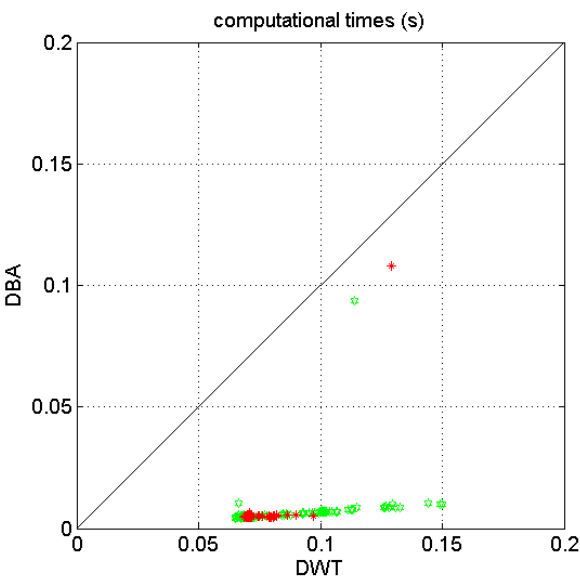
Figure 5. Computation times, in seconds, for multi scale DWT and DBA, using linear interpolation (green) and ‘nearest neighbor ap- proximation’ (red). The ratio between the mean computation times is 10.91 for the first case and 10.56 for the latter. This is dependent on the dilations used, since the time save for larger windows is higher than for small